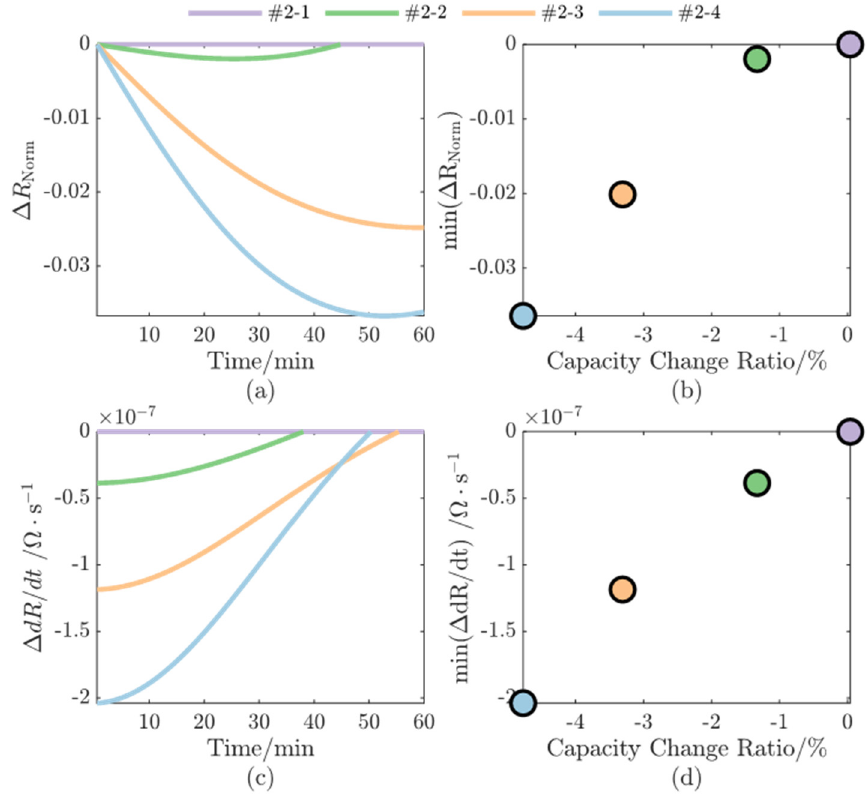
Figure 8. The difference of R Norm and dR/dt between normal battery and lithium plating battery. ( a ) R Norm difference; ( b ) The minimum of R Norm difference versus capacity change ratio; ( c ) dR/dt difference; ( d ) The minimum of dR/dt difference versus capacity change ratio.